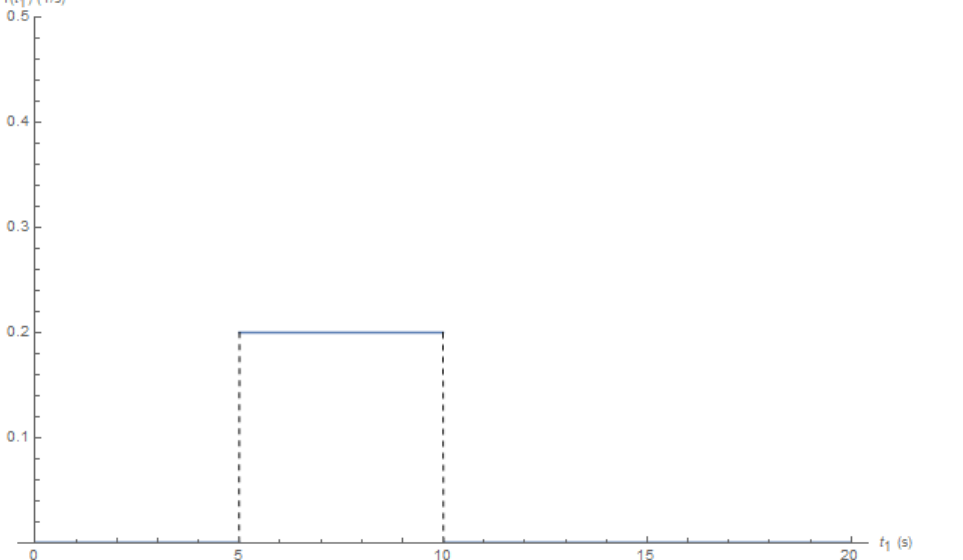
Figure 2. Uniform distribution probability density function of t 1 ; in the illustration, we assumed T = 5 and t D =